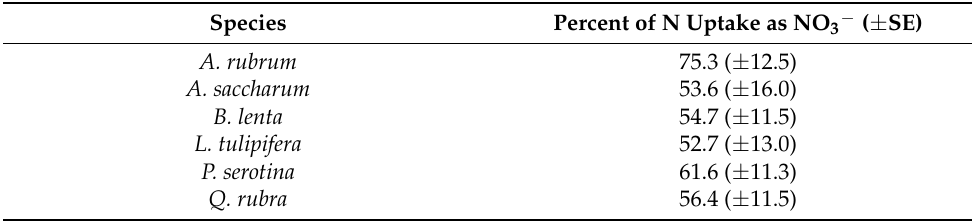
Table 1. The percent of total uptake of mineral N as NO 3 − for six major overstory trees at the FEF, measured in situ using 15 N-labeled NO 3 − and NH 4+